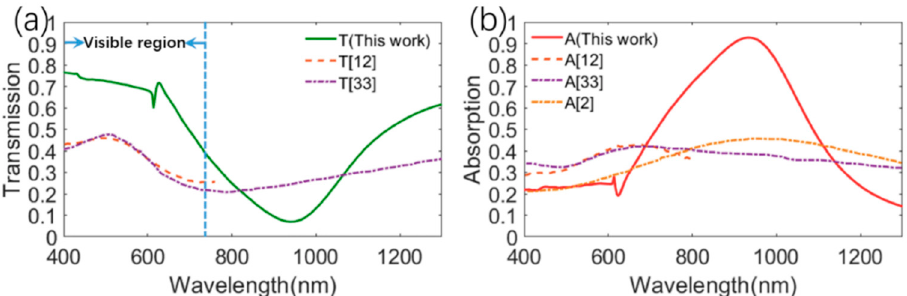
Figure 6. Comparisons of ( a ) transmission and ( b ) absorption performances between our metasurface absorbers and other reported transparent absorbers [2,12,33].